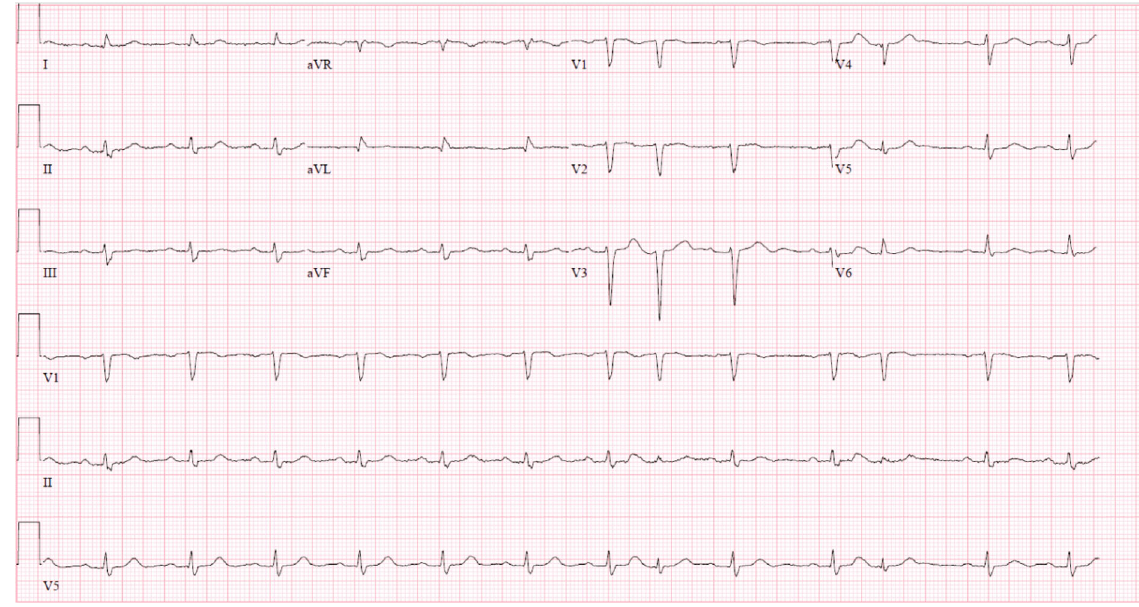
Figure 5: 12-lead EKG obtained after NG tube placement and patient reverting back to normal sinus